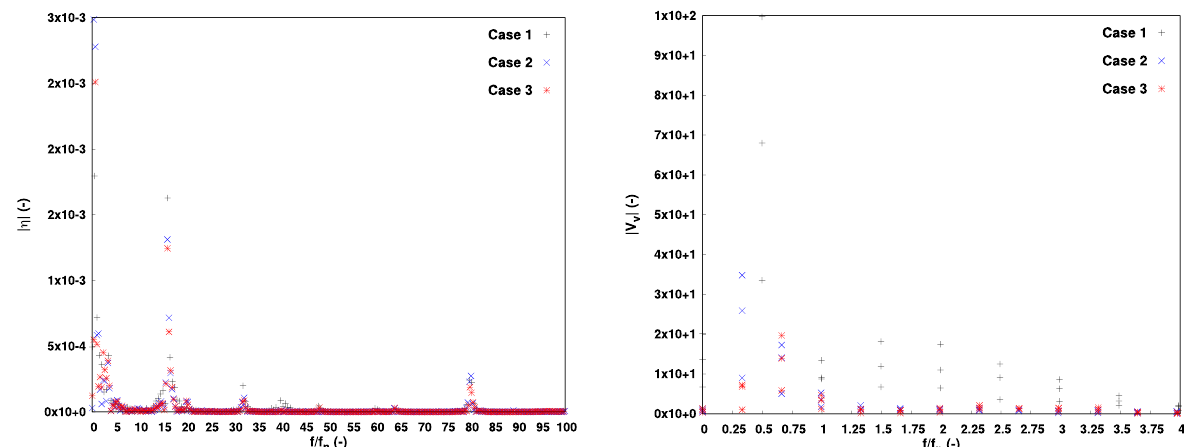
Figure 6. Magnitude of the Fourier transform of the efficiency (left) and volume of vapour (right) signals.